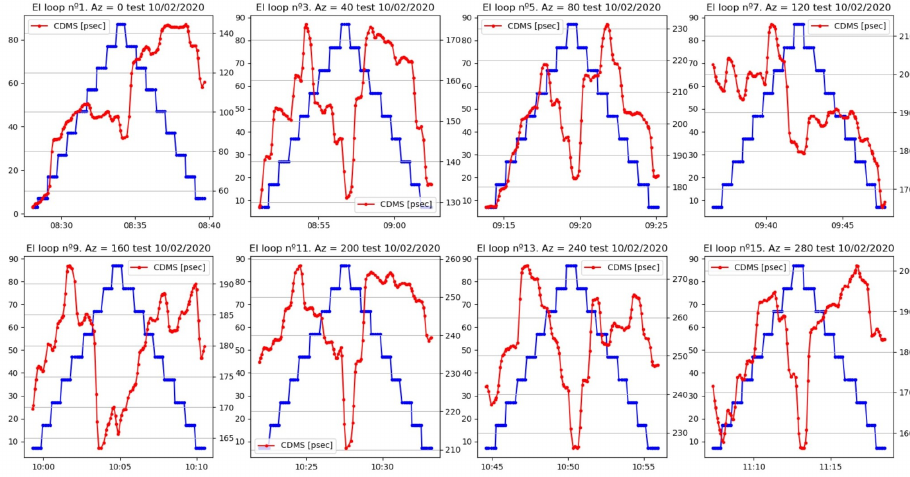
Figure 22. Zoom of the cable delay evolution during elevation